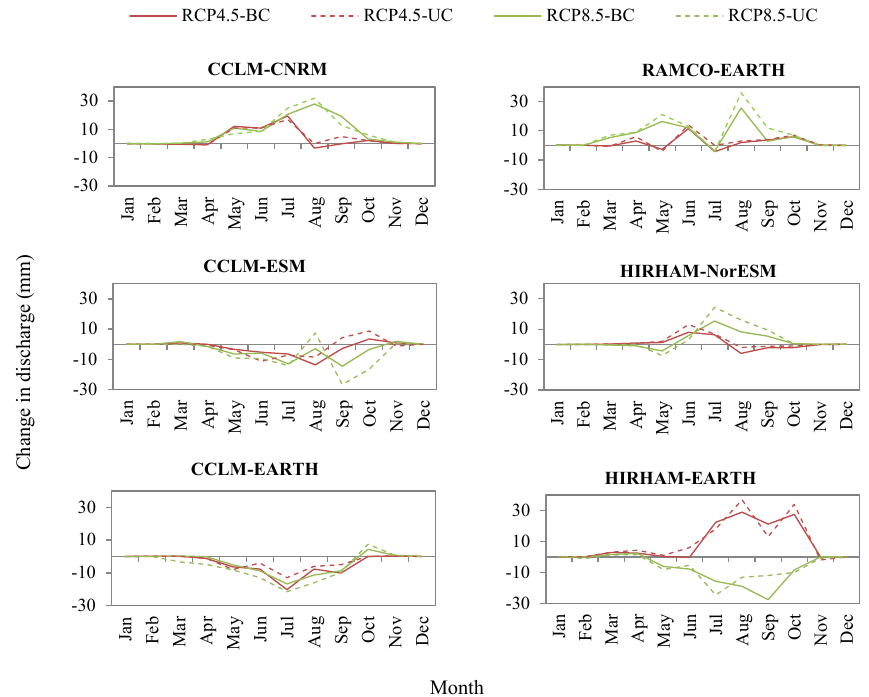
Figure 9. Monthly discharge change between the reference period (1971–2000) and the future period (2021–2050) under emission scenarios RCP4.5 and RCP8.5. BC and UC refer to bias corrected and non bias corrected, respectively.